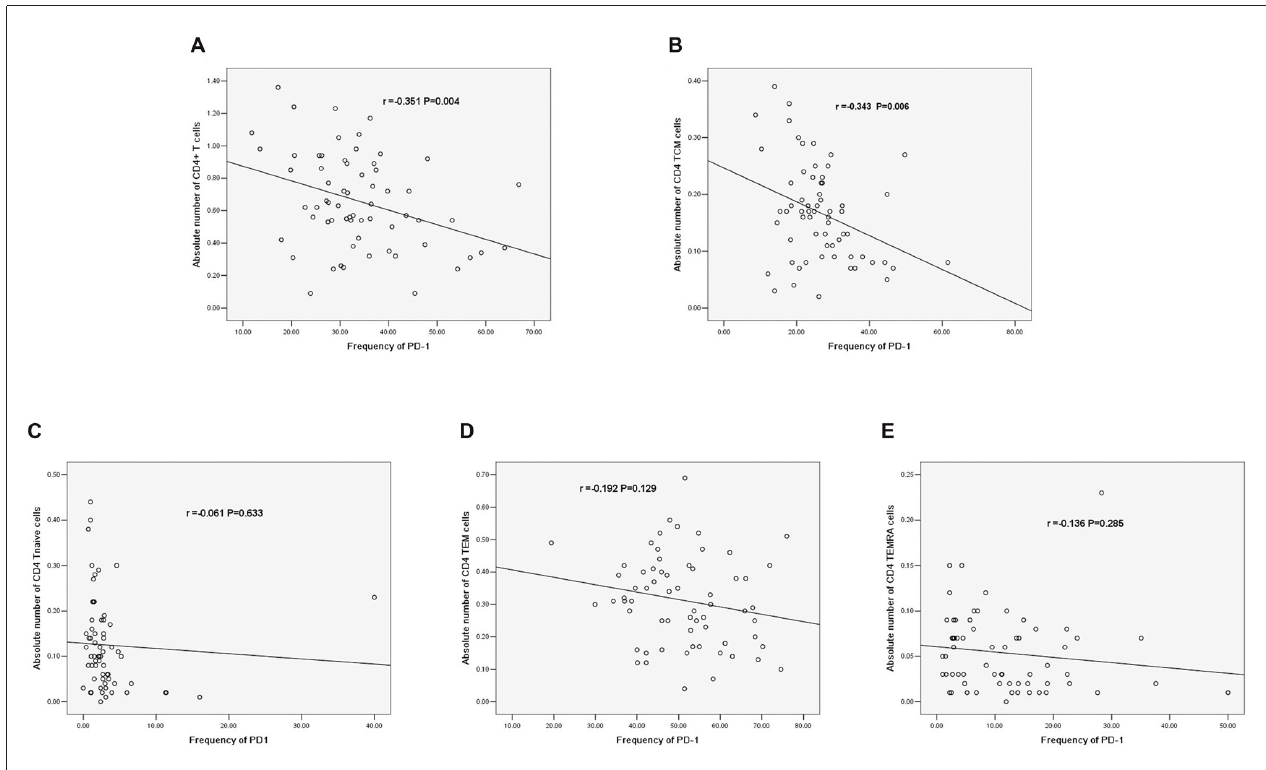
FIGURE 8 | (A) Correlation between PD-1 and the absolute number of CD4 + T cells. (B) Correlation between PD-1 and the absolute number of CD4 + TCM cells. (C) Correlation between PD-1 and the absolute number of CD4 + T naïve cells. (D) Correlation between PD-1 and the absolute number of CD4 TEM cells. (E) Correlation between PD-1 and the absolute number of CD4 + TEMRA cells (correlation determined by Pearson correlation